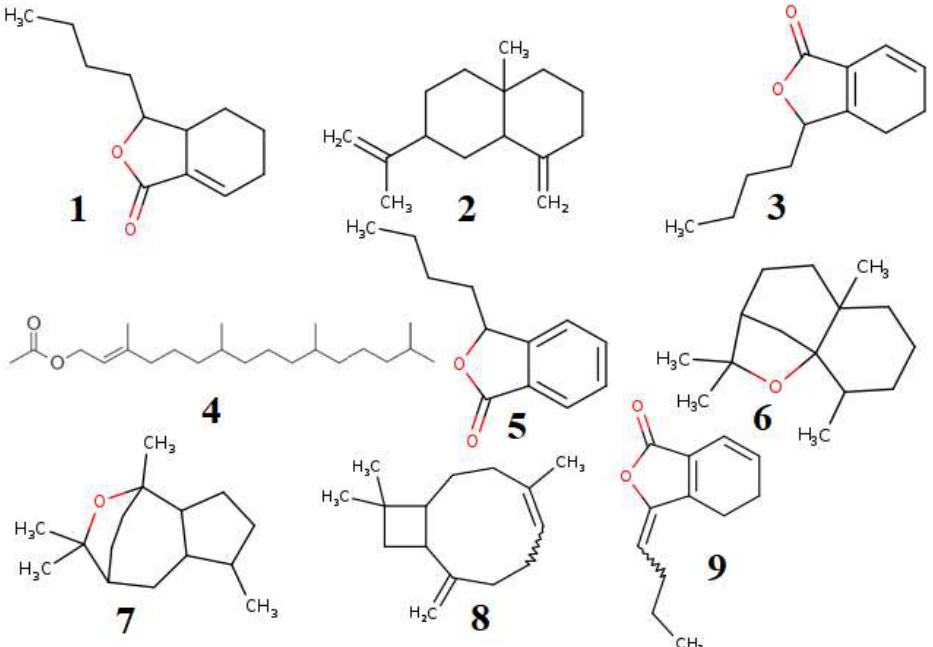
Figure 4. Major volatile compounds present in the AGO, Isocnidilide ( 1 ), β -Selinene ( 2 ), Senkyunolide ( 3 ), Phytyl acetate ( 4 ), 3-Butylphthalide ( 5 ), Dihydroagarofuran ( 6 ), Kessane ( 7 ), Caryophyllene ( 8 ), and Ligustilide ( 9 ).